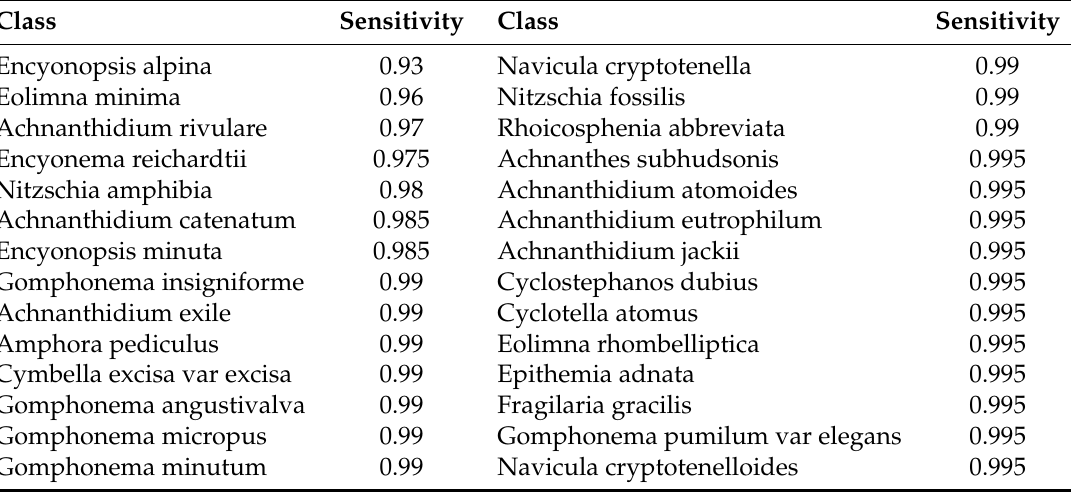
Table 8. Sensitivity of top-30 error-prone